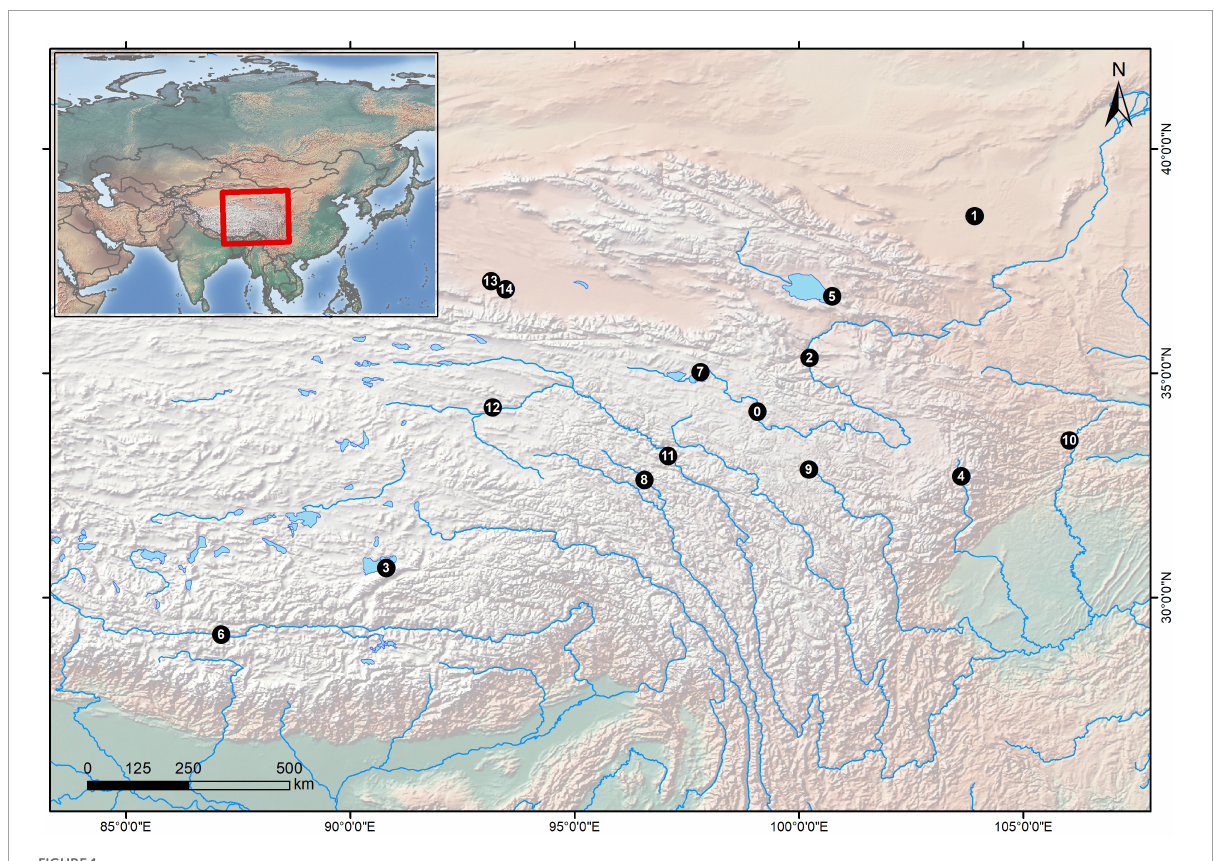
FIGURE1 Sampling localities of the specimens. The black points are sampling sites, and the numbers in those points refer to the locality numbers in Table 1